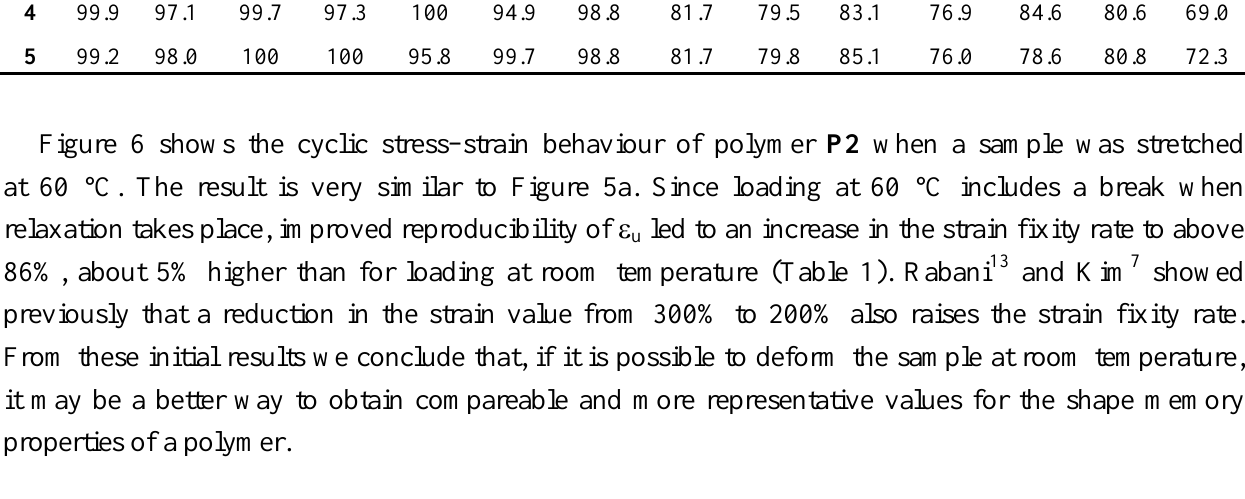
Figure 6. Cyclic stress-strain behaviour of P2 when the sample was deformed at 60